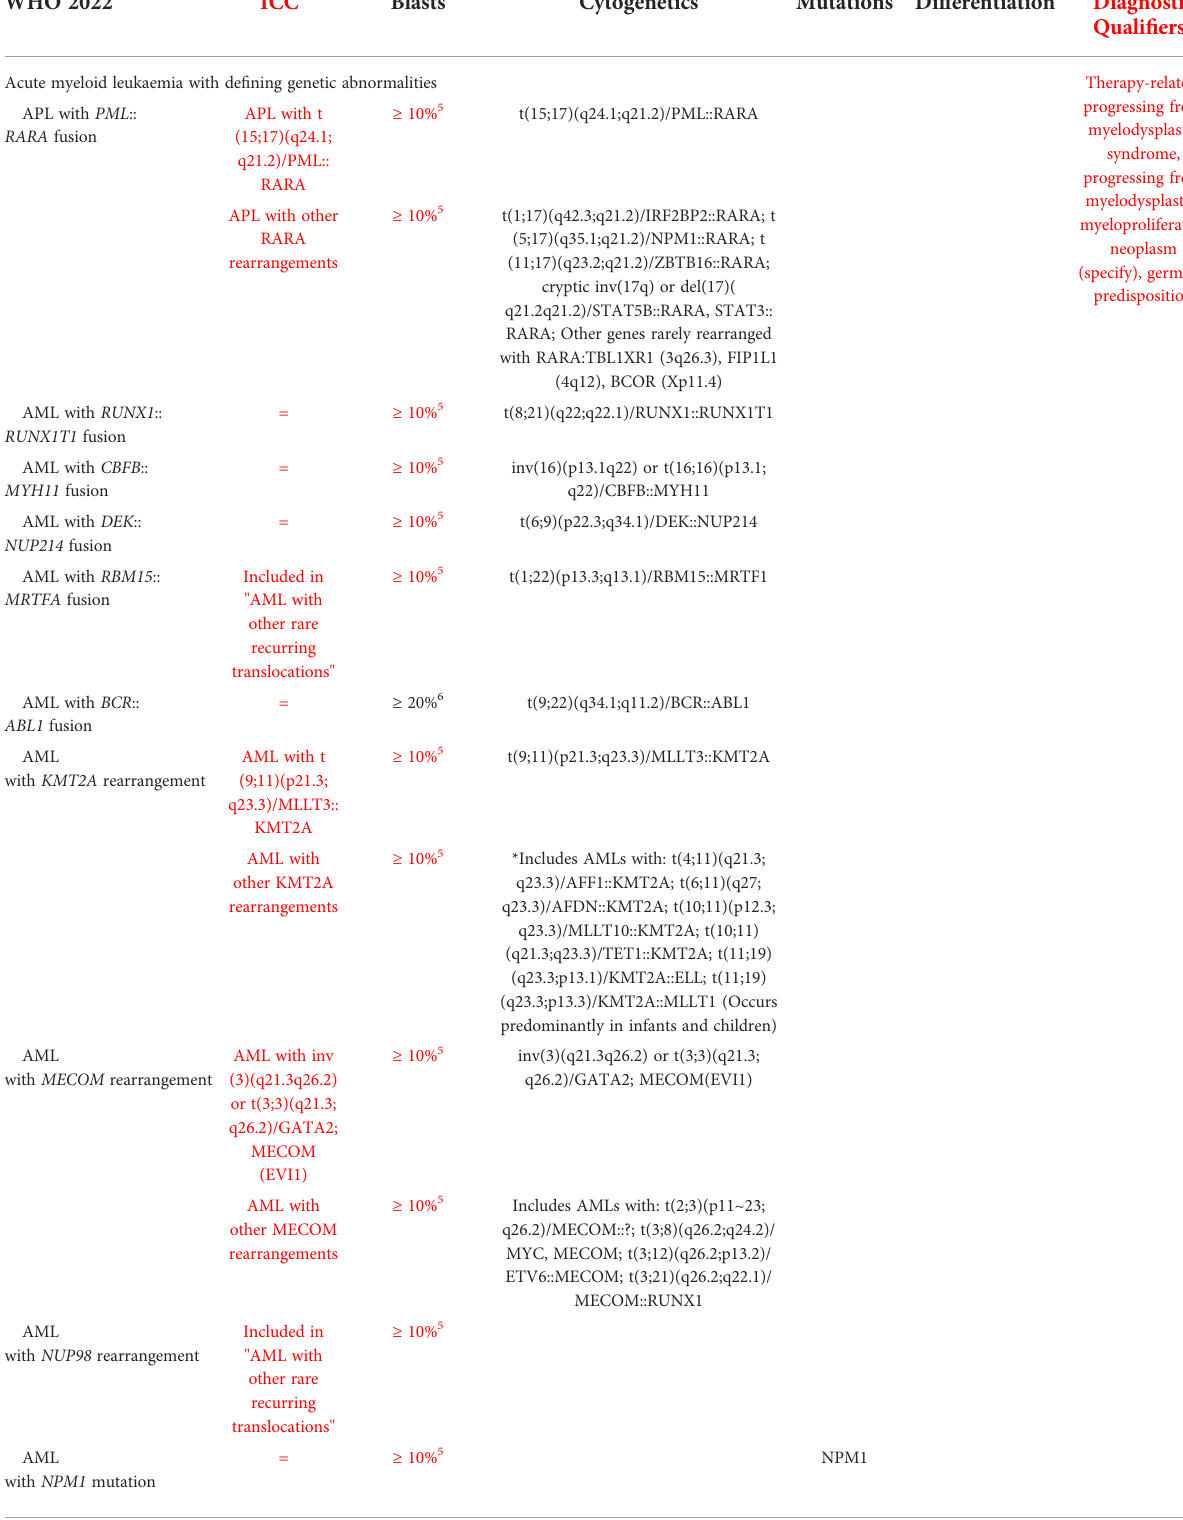
TABLE 2 A comparison of the WHO, ICC, and ELN 2022 classi fi cation systems for AML. Criteria speci fi c to the ICC, ELN 2022, or both classi fi cation systems are color coded red, blue, and purple, respectively. Classi fi cation of Acute Myeloid Leukemias (AML) 1,2,3 . WHO 2022 1 ICC 2 Blasts Cytogenetics Mutations Differentiation Diagnostic